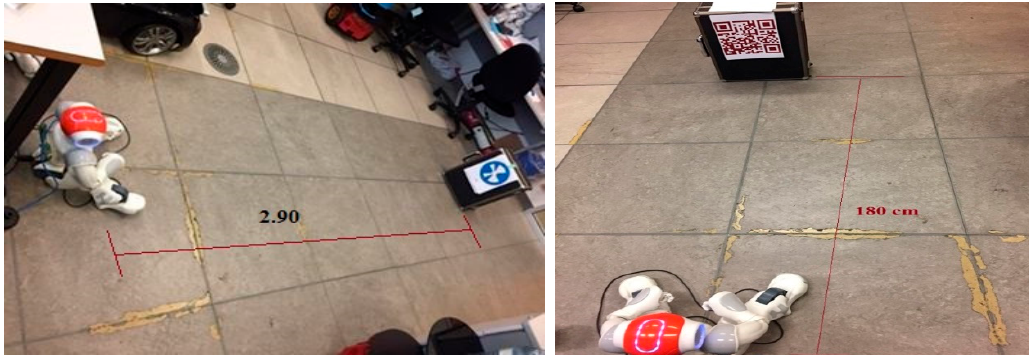
Figure 9. Detected NAO mark and QR codes by the NAO and their distances.